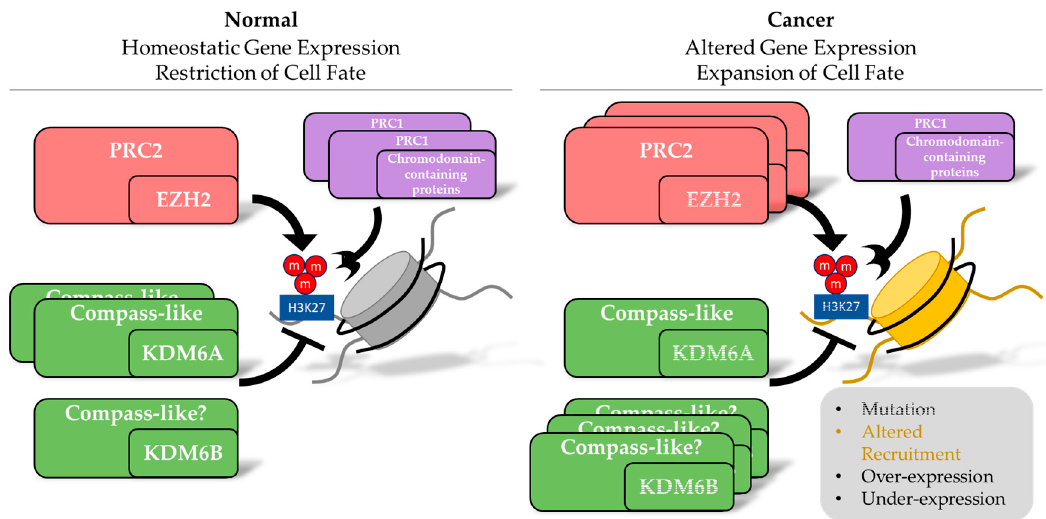
Figure 1. Regulated addition and removal of H3K27me3 is critical for maintaining cellular homeostasis. Functioning as members of protein complexes, the indicated enzymes possess the biochemical activity to alter the methylation state at H3K27 while chromodomain-containing proteins, among others, have the capacity to interpret the methylation state. Disruption in this balance, whether through mutations (indicated by strikethroughs), altered recruitment (indicated by change in nucleosome color), over-expression (indicated by additional boxes) or under-expression (indicated by fewer boxes), has the potential to drive and/or support tumorigenesis through the expansion of cell fate identity.